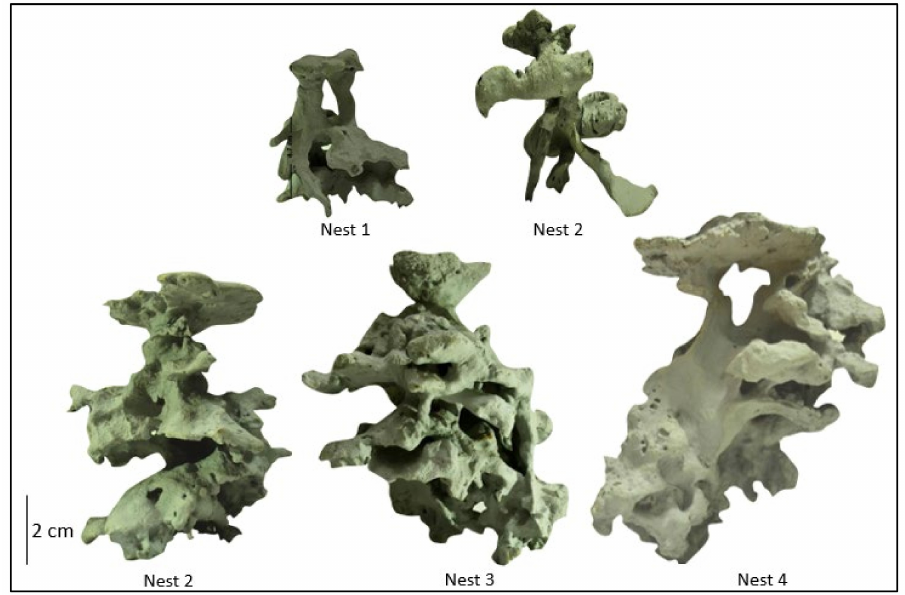
Figure 4. P. fallax nests molded with dental gypsum, showing the ant nest architecture in rehabilitated sites of the Cerrej ó n mine in La Guajira,